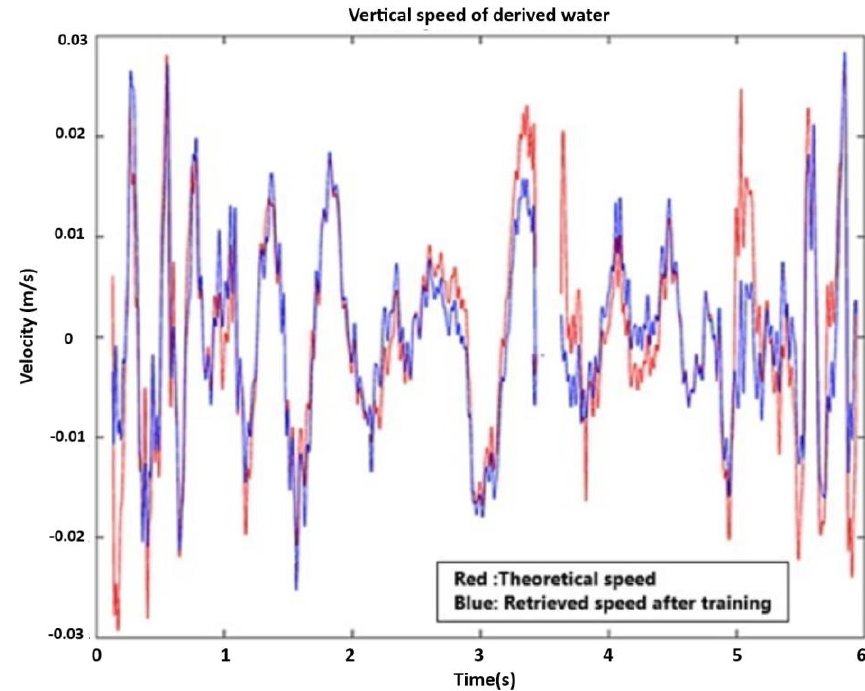
Figure 9. Vertical speed profile in theoretical and training steps.